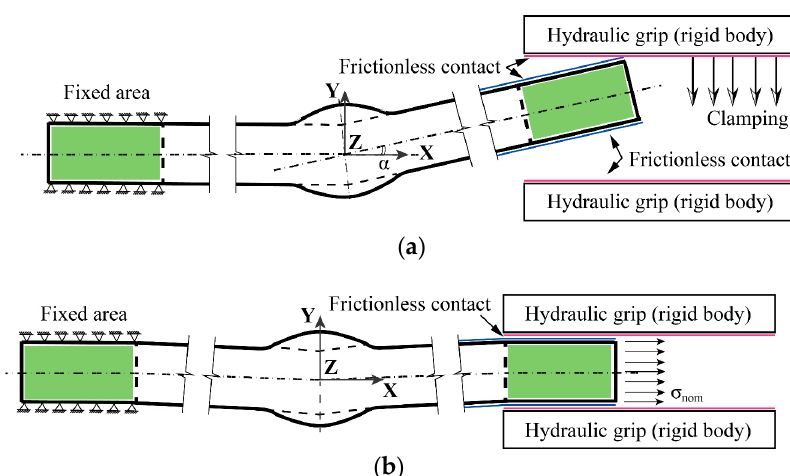
Figure 5. Two-step FE analysis for a distorted butt joint: ( a ) clamping; ( b ) tension.